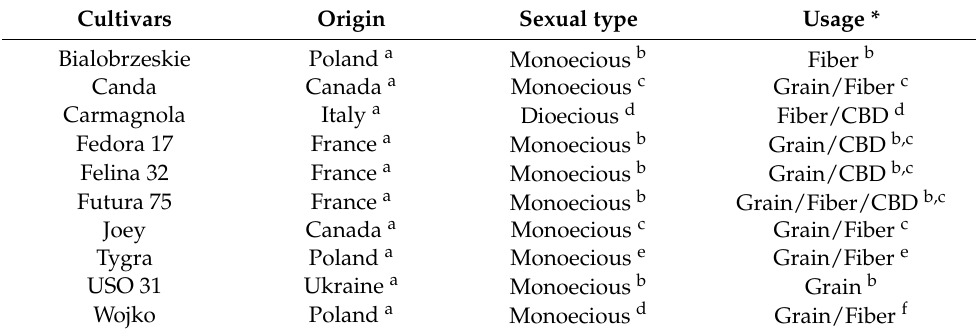
Table 1. Some characteristics of industrial hemp cultivars planted at the Research and Demonstration Farm, Virginia State University. Cultivars Origin Sexual type Usage * Bialobrzeskie